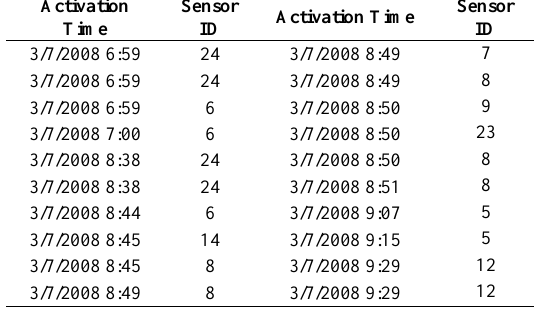
Table 2. Relation matrix for a single day. Sensor1